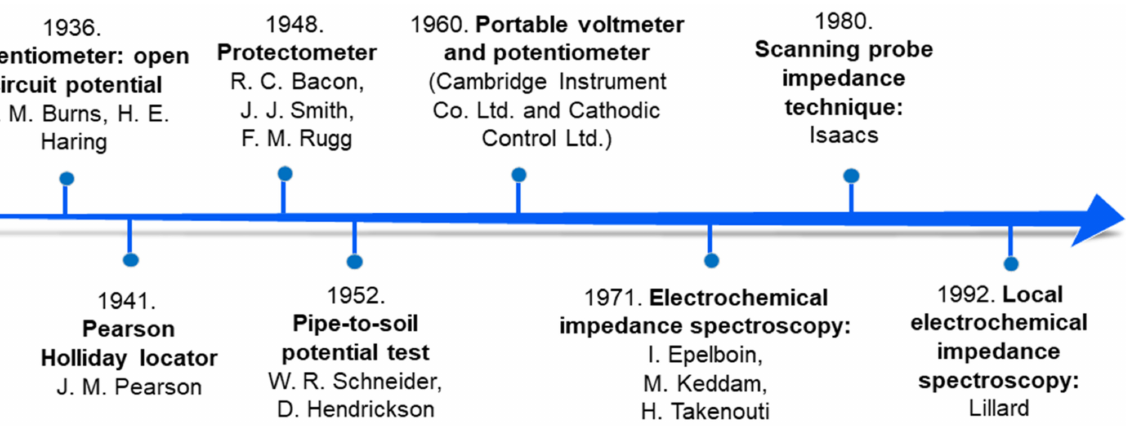
Figure 1. Timeline of milestones in advances of polymeric coating characterization